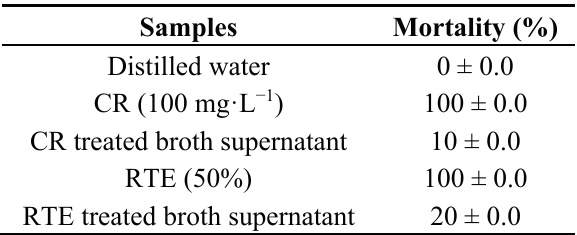
Table 6. Mortality of D. magna exposed to CR dye (100 mg·L − 1 ), RTE (50%) and their culture supernatants obtained after treatment with PUF immobilized microbial consortium in an upflow column